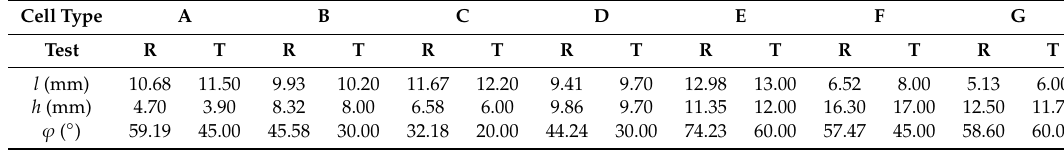
Table 4. Comparison of real (R) and theoretical (T) cell dimensions.